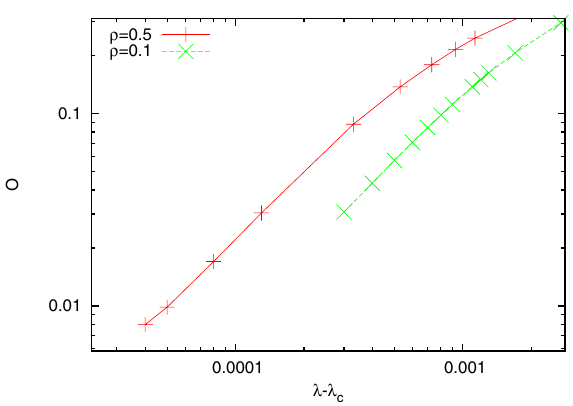
Fig. 2. Variation of average opinion with (cid:2) near critical points for di®erent values of (cid:1) . The value of (cid:4) is 1 : 15 (cid:5) 0 : 01